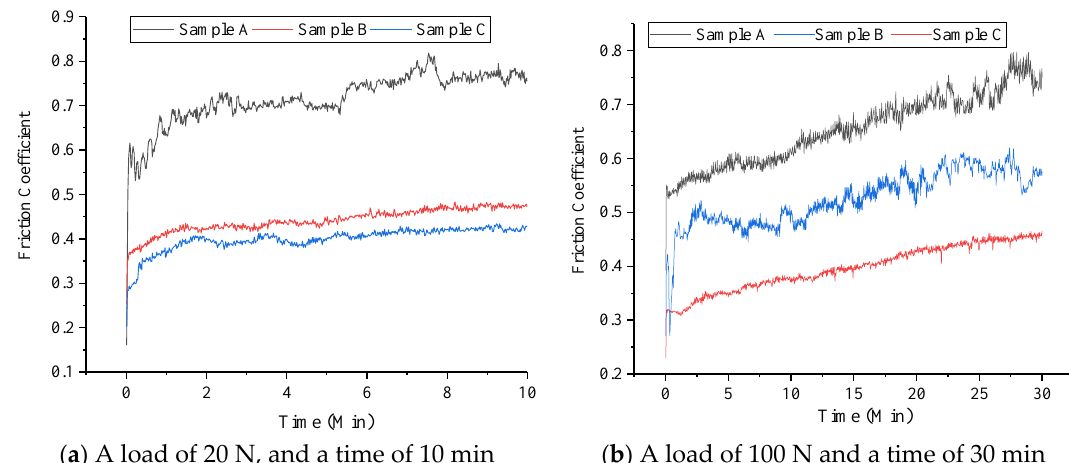
Figure 8. Coefficient of friction of different test conditions. ( a ) a load of 20 N, and a time of 10 min; ( b ) a load of 100 N and a time of 30 min.